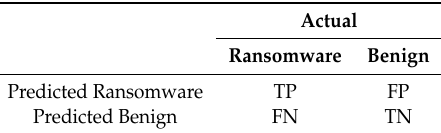
Table 1. Confusion